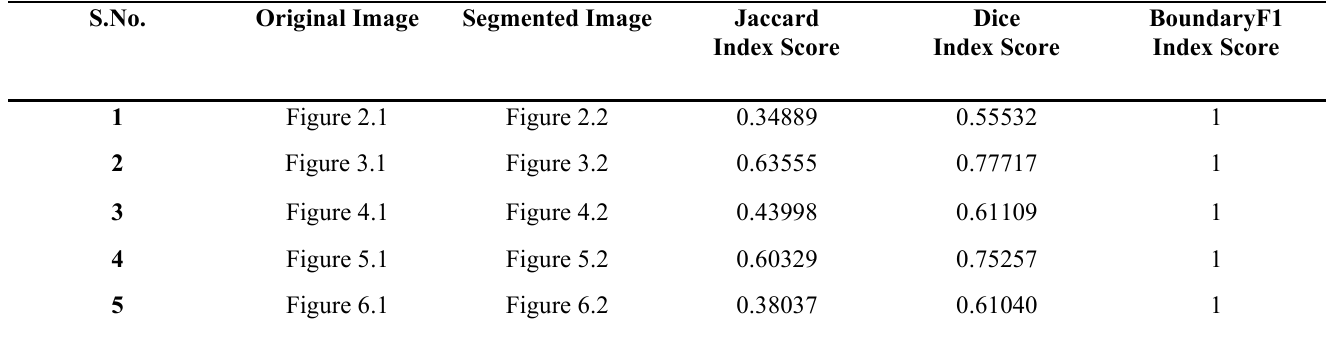
Table 1. Evaluation of Similarity Matrices between original and Segmented Image